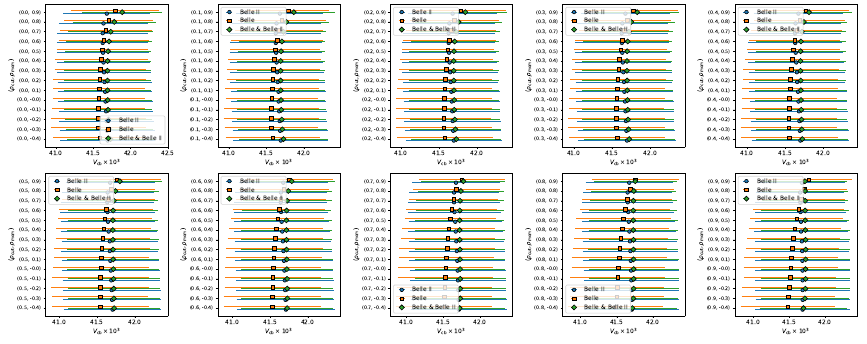
Figure 11 . Fit results for | V cb | for different combinations of correlation parameter values.